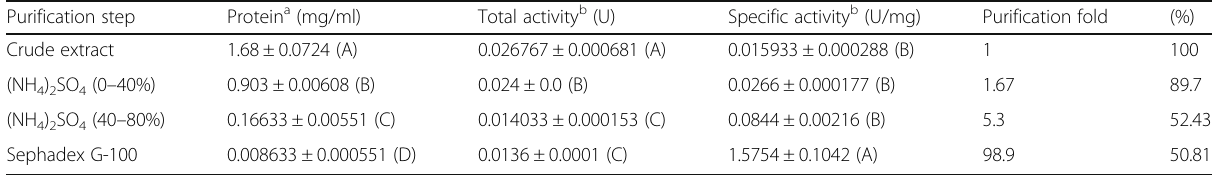
Table 1 Purification process of fat body lipase from G. mellonella